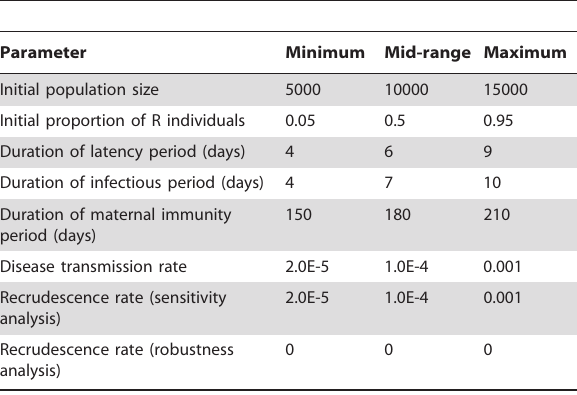
Table 1. Experimental design for the sensitivity analysis and robustness